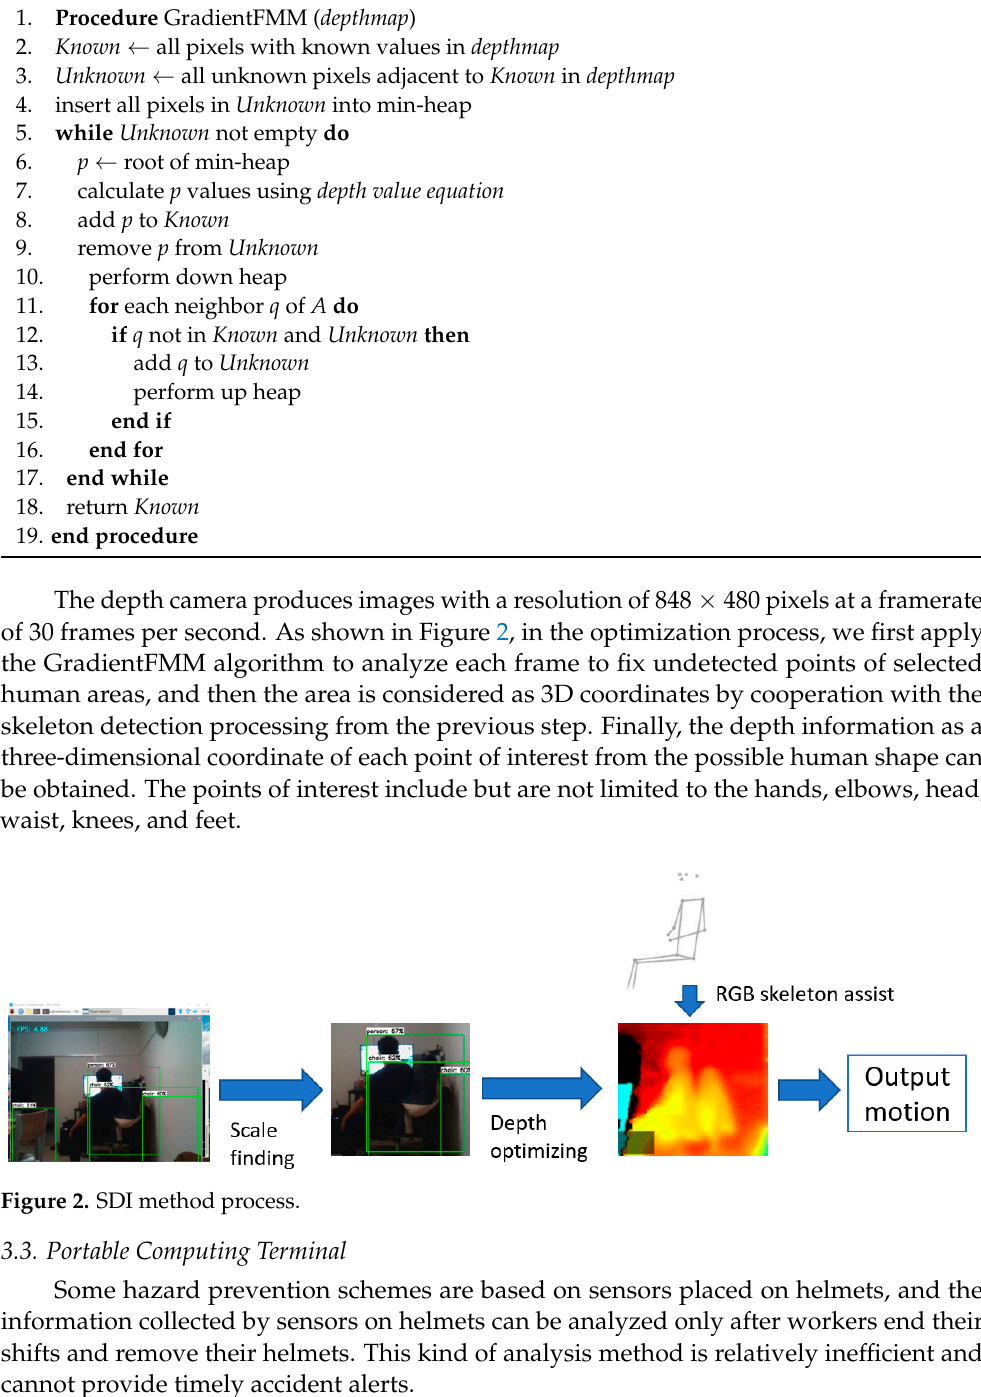
Algorithm 1: Gradient Fast ‐ Marching Method (GradientFMM)